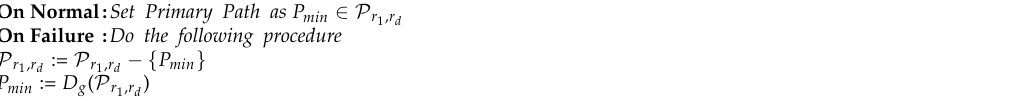
Algorithm 1 Find the shortest path with Dijkstra from End-to-End based on Graph G On Normal: Set Primary Path as P min ∈ P r 1 , r d On Failure : Do the following procedure